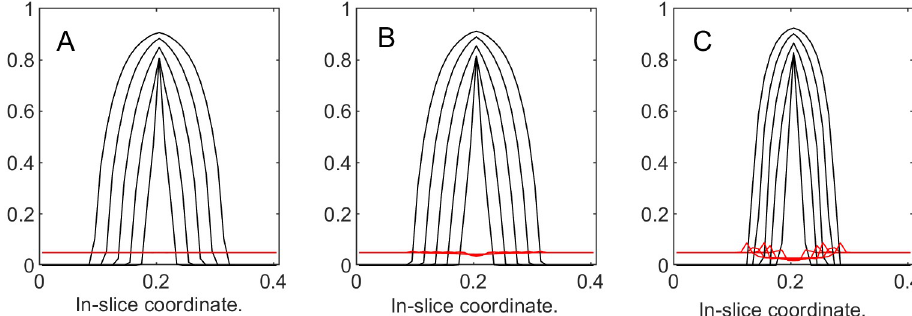
Fig 12. Tumor and ECM dynamics for various ECM strain-stress coefficients. Superimposed “slices” through the center of the tumor at times 100, 200, ... , 500. Tumor volume fractions—black, ECM—red. A: k 3 = 1 (low excess pressure). B: k 3 = 5. C: k 3 = 25 (high excess pressure). Note that higher k 3 means higher resistance from ECM and slower tumor growth. Note also that ECM becomes visibly deformed at higher k 3 values, indicating formation of a